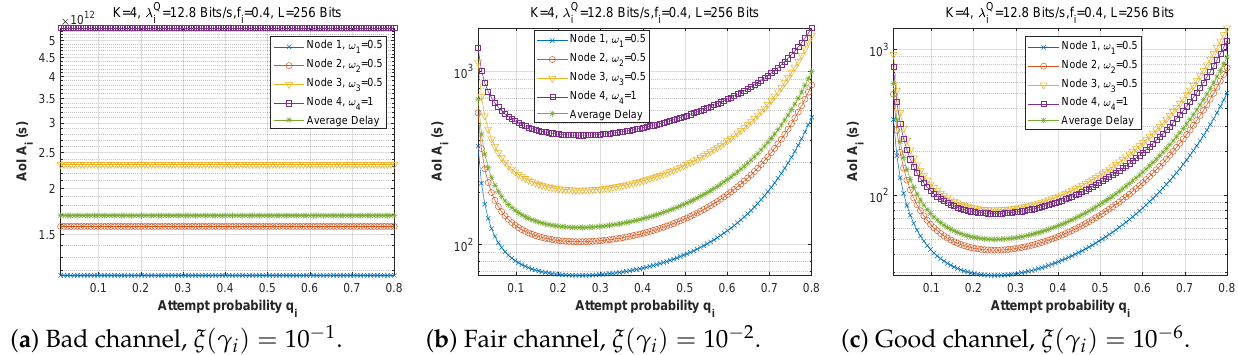
Figure 25. Setting 1: The AoI experienced at each mobile device as a function of attempt probability for various bit error rates ξ ( γ i )